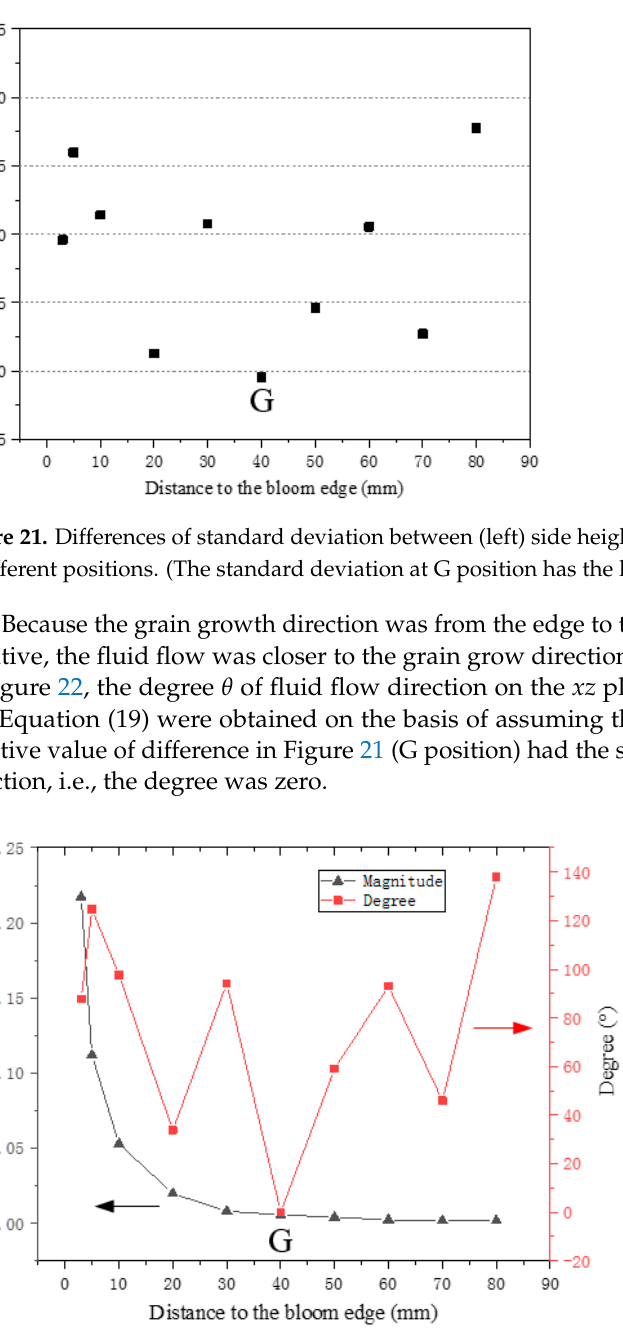
Figure 22. The magnitude and direction degree θ of interdendritic fluid flow velocity V if f at different positions. (The direction degree θ at G position is